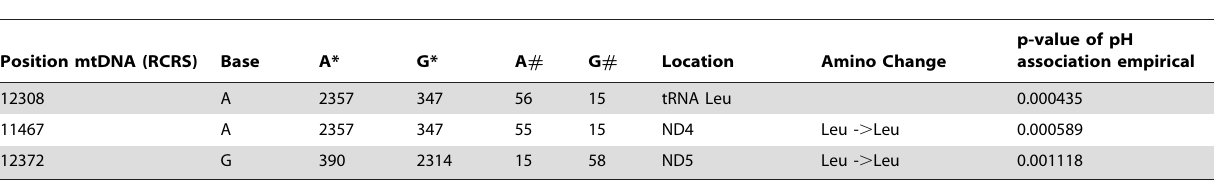
Table 6. pH in postmortem brain showed significant association with three mtDNA SNPs.